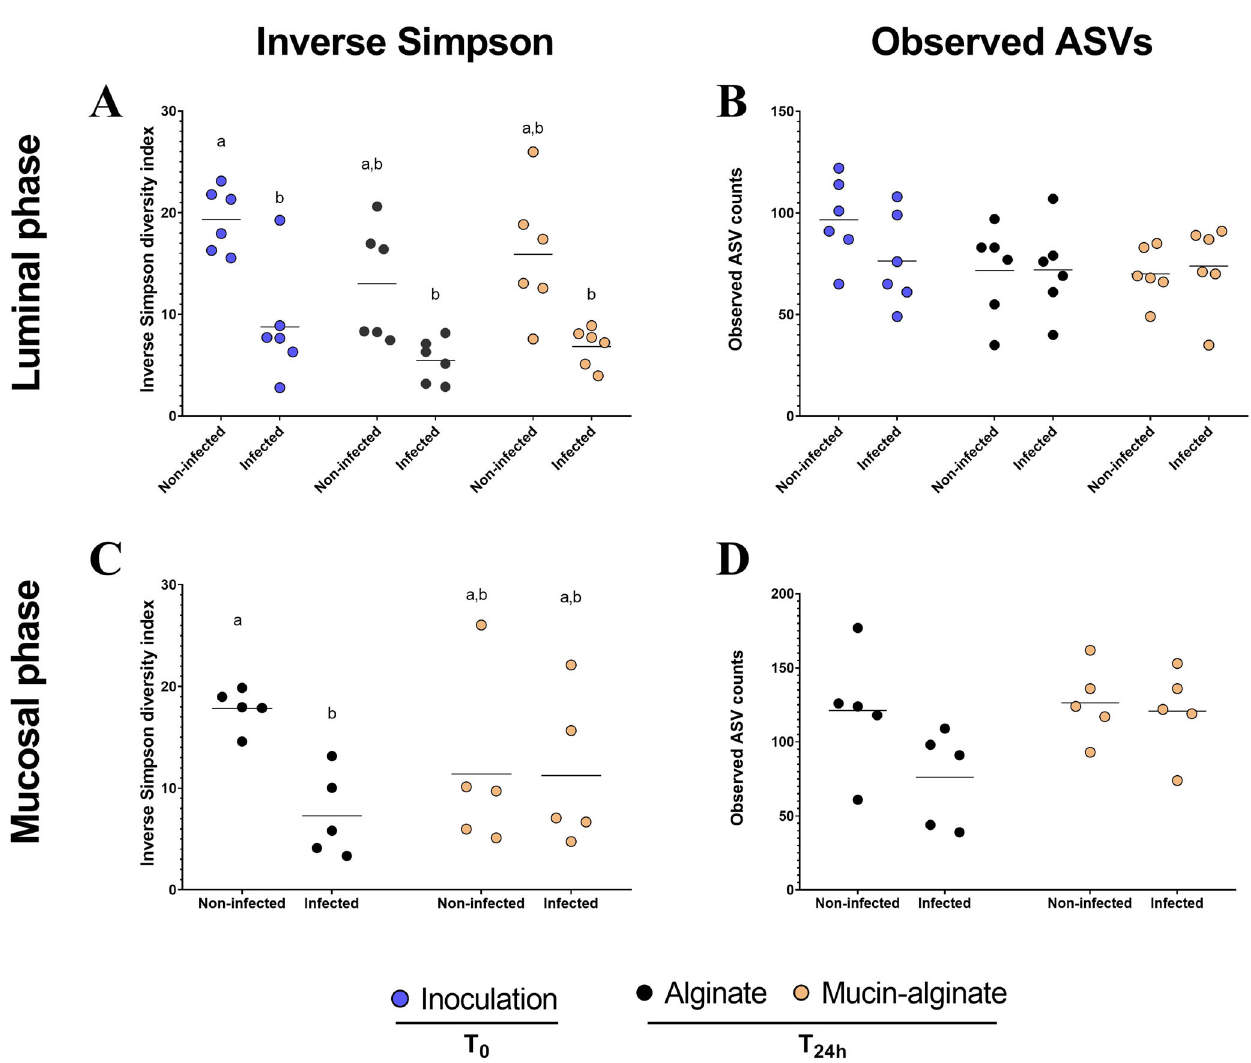
Fig. 6 Impact of mucin on ETEC modulation of fecal microbial communities as determined by α -diversity. Batch experiments were performed using feces from 6 healthy donors, challenged or not with ETEC strain H10407, with mucin-alginate beads or alginate beads (as a control). The graphs represent the variation of the microbiota α -diversity at the ASV level at inoculation (T0) and after 24 h (T24h) between bottles including mucin-alginate beads and alginate beads in luminal ( A , B ) and mucosal compartments ( C , D ). The parameters analyzed included species richness represented by Observed ASVs ( B, D ) and evenness represented by Inverse Simpson index ( A , C ). Blue, black and orange dots represent individual biological replicates at the beginning of the experiment (T0) or after 24 h (T24h) in the alginate and mucin- alginate beads conditions, respectively, while black bars represent the mean. Results that are not signi fi cantly different from each other according to Tukey ’ s multi-comparison are grouped under the same letter ( p <